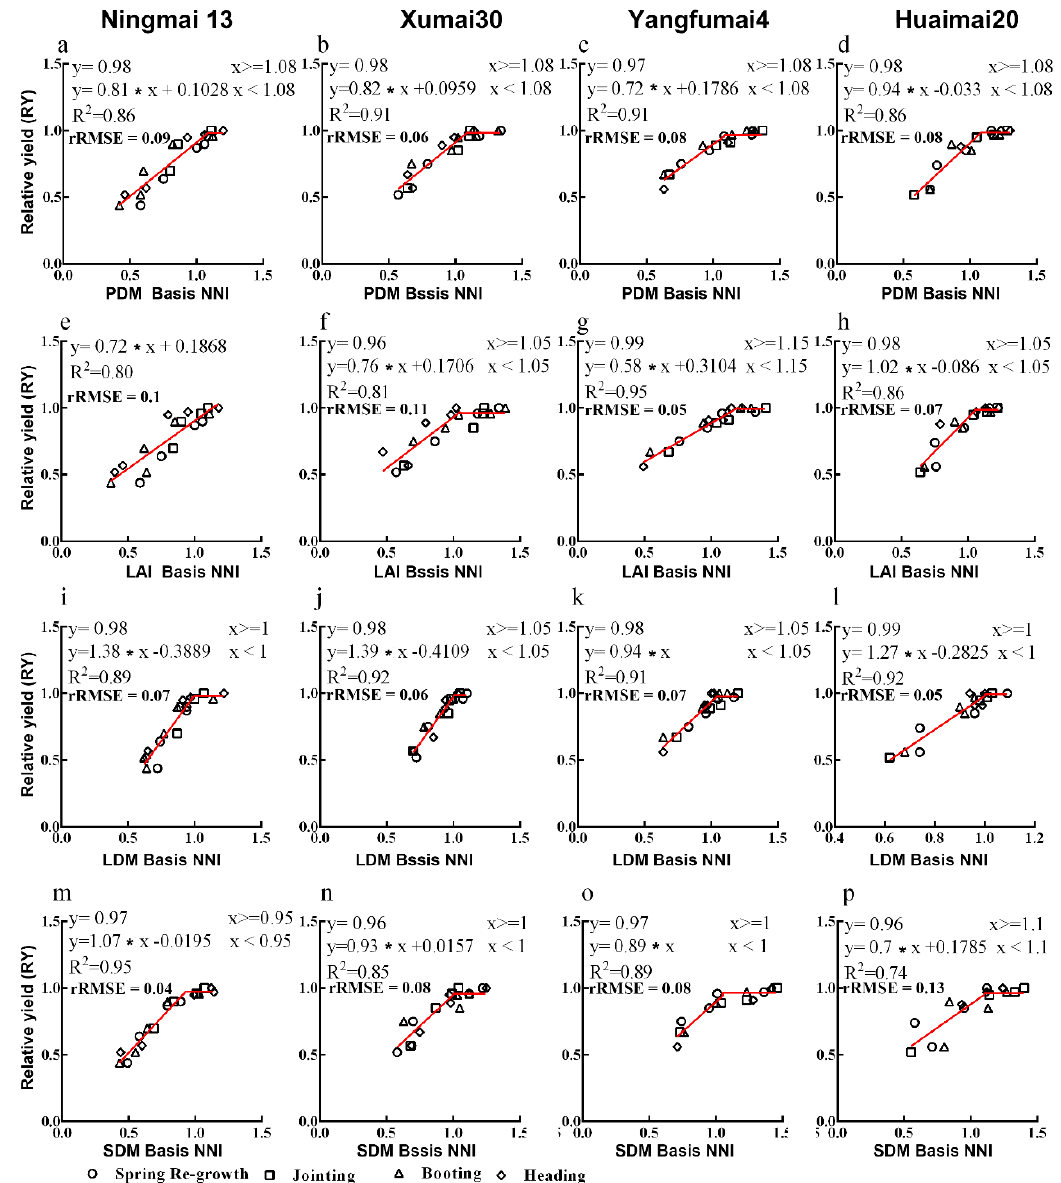
Figure 7. Relationships between relative yield (RY) and nitrogen nutrition index (NNI) on the basis of different cultivars’ critical N dilution curves (dataset from experiments 4 and 5; ( a , e , i , m ): Ningmai13; ( b , f , j , n ): Xumai30; ( c , g , k , o ): Yangfumai4; ( d , h , l , p ): Huaimai20).